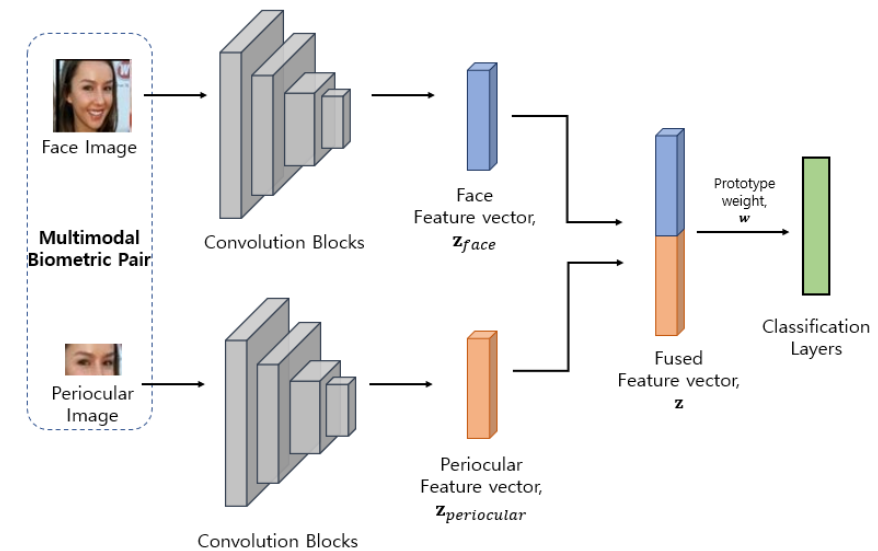
Figure 4. The feature extraction and fusion